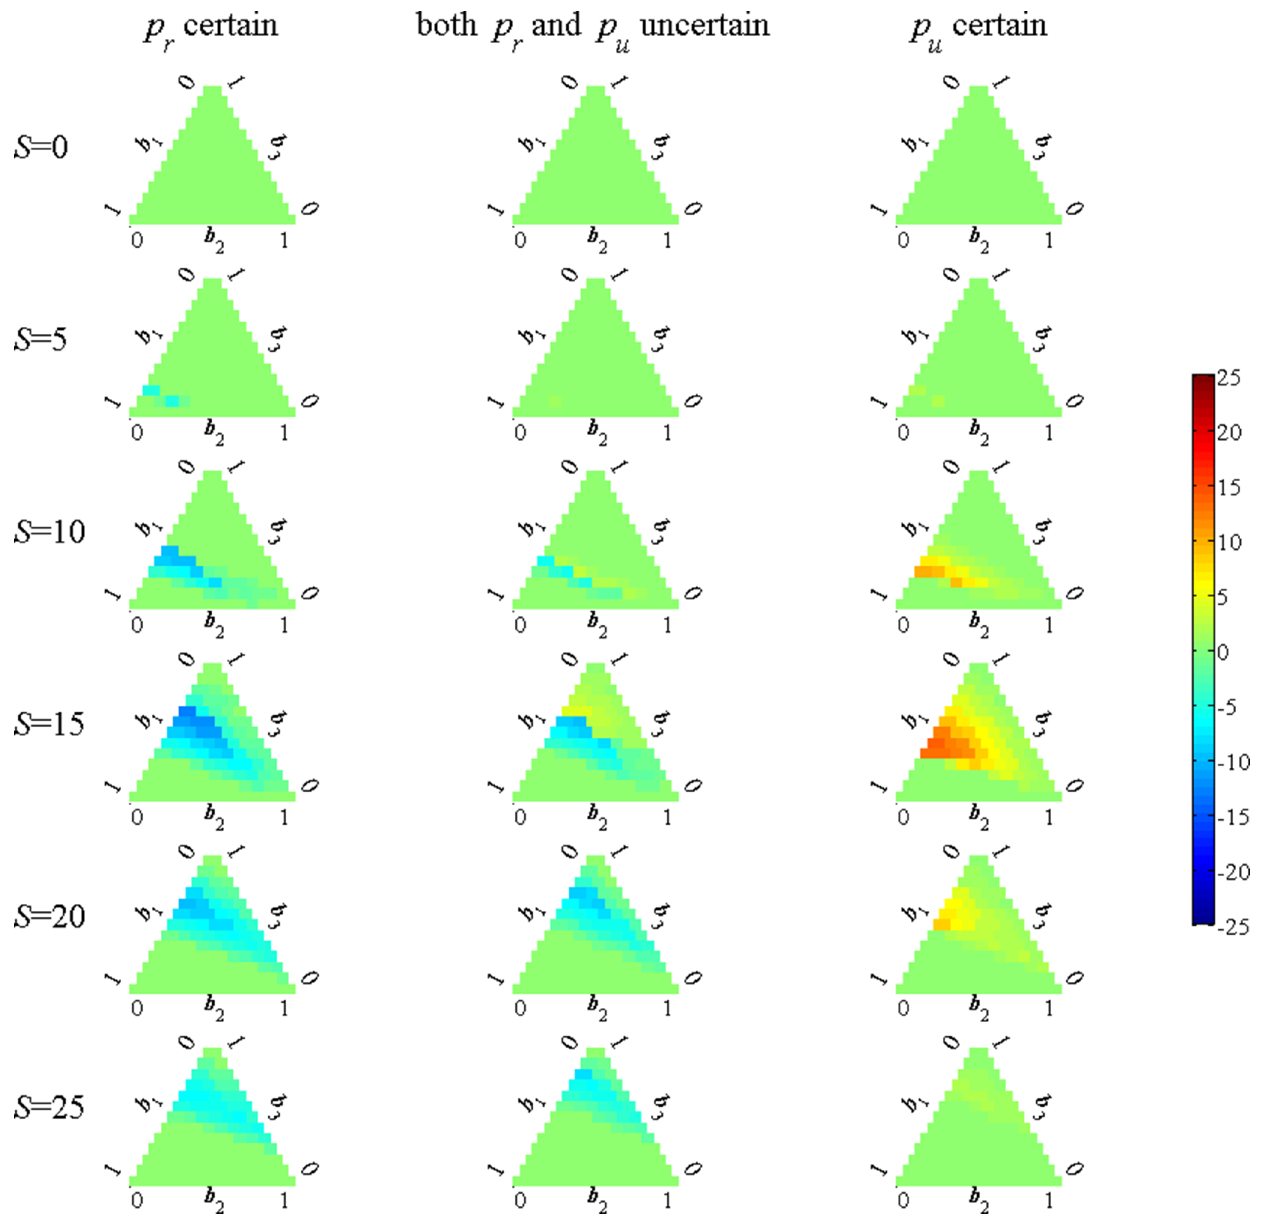
Figure 5. Probing activity with the signal equal to the number of successes. Green values indicate no probing activity, blue values represent fewer restrictions with the adaptive strategy, yellow/red values indicate more restrictions with the active strategy. function of the belief weights. The lower left ([1 0 0]) corner corresponds to complete certainty in the no-disturbance model where no restrictions are ever optimal. The lower right ([0 1 0]) corner corresponds to complete certainty in the moderate disturbance effect case. The upper ([0 0 1]) corner corresponds to the complete certainty in the strong disturbance effect case. The colors in the plots represent the optimal number of restrictions, ranging form 0 to 25. It should be noted again that the number of restricted sites can never be greater than the number of occupied sites. Hence, by definition, the plots for S = 0 in the top rows of subplots are all blue.